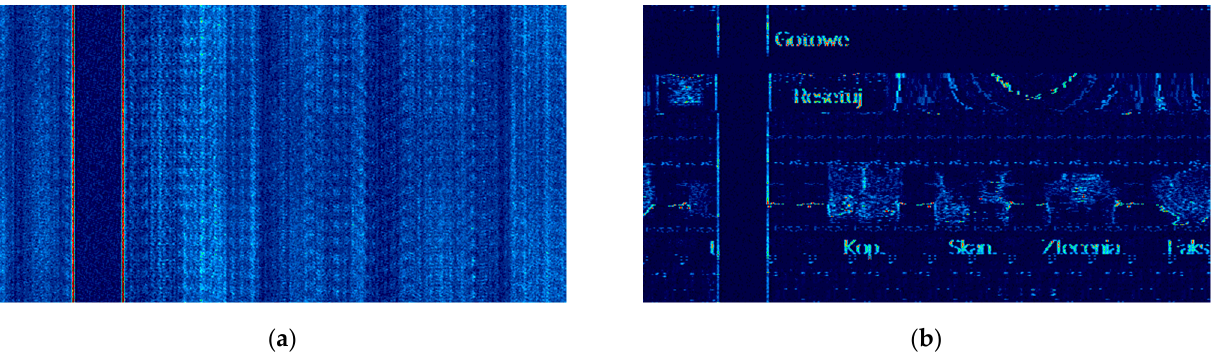
Figure 18. Images reconstructed from the revealing emission signal measured at the frequency f o = 235 MHz, for the number of lines of this image determined in accordance with the criterion of the maximum value of the measures presented in Figure 17: ( a ) the number of image lines determined in accordance with method V ( B = 273, the number of lines smaller than required), ( b ) number of image lines determined in accordance with method I, II, III, IV, VI, and VII ( B Corr = 288, correct number of lines).